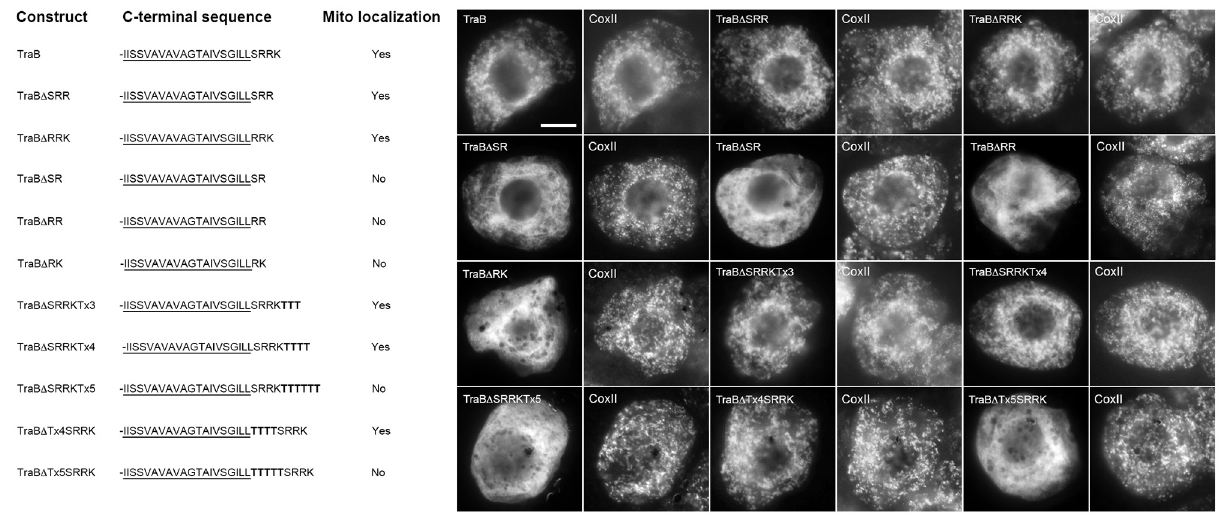
wild-type) CTS; additional amino acid residues inserted into the TraB CTS (i.e., threonines) are bolded. Mitochondrial localization (indicated as “Yes” or “No”) wasassessedbasedoncolocalization(orlackthereof)oftheexpressedprotein and endogenous mitochondrial CoxII. Shown on the right in both are representative immuno-epifluorescence micrographs illustrating the localization of the various constructs shown on the left . Each micrograph is labeled with the name of the expressed Myc-tagged wild-type TraB or CTS mutant version of TraB, or endogenous CoxII. Bar = 10 μ m.